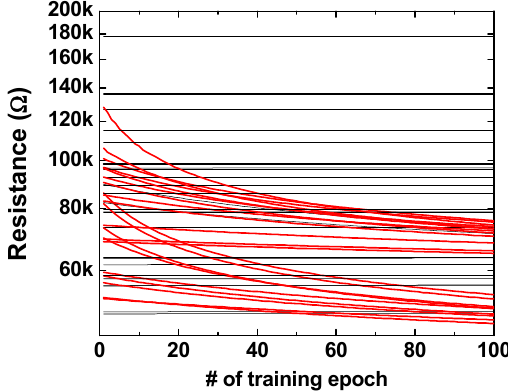
Figure 9. Resistance change of the positive memristors as a function of training epochs.